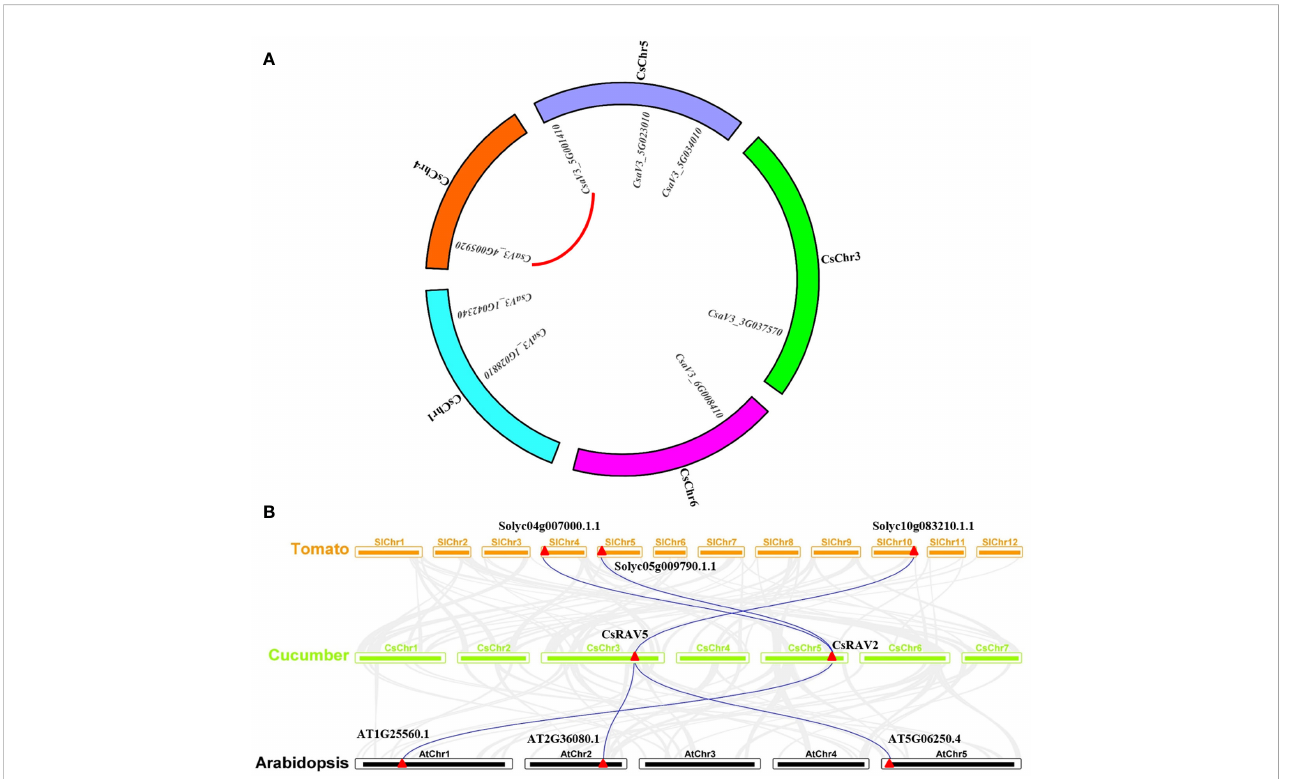
FIGURE 3 Gene duplication and synteny analysis of CsRAV genes. (A) Chromosome distribution and interchromosome relationships of CsRAV genes. The red line indicated segmental duplication gene pair. (B) Synteny analysis of RAV genes from cucumber, tomato and Arabidopsis . Gray lines represented the collinear blocks between cucumber and tomato or Arabidopsis ; Blue lines represented the collinear blocks of RAV genes between cucumber and tomato or Arabidopsis .